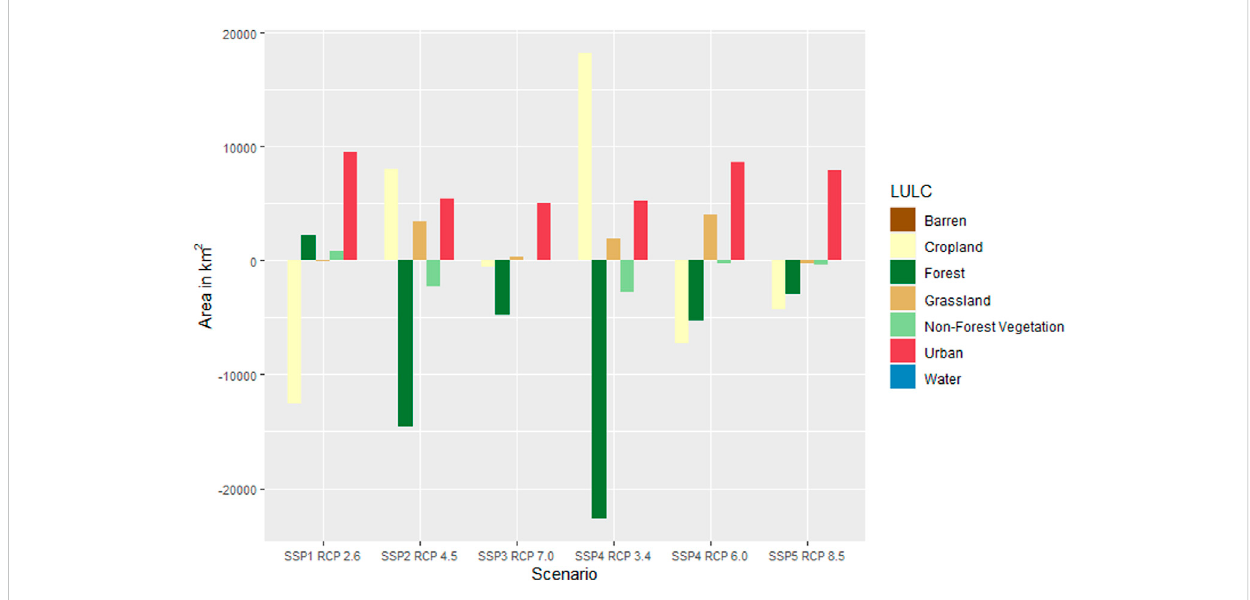
LULC transition between 2015 and 2050 scenarios for SEA urban clusters — scenario-based